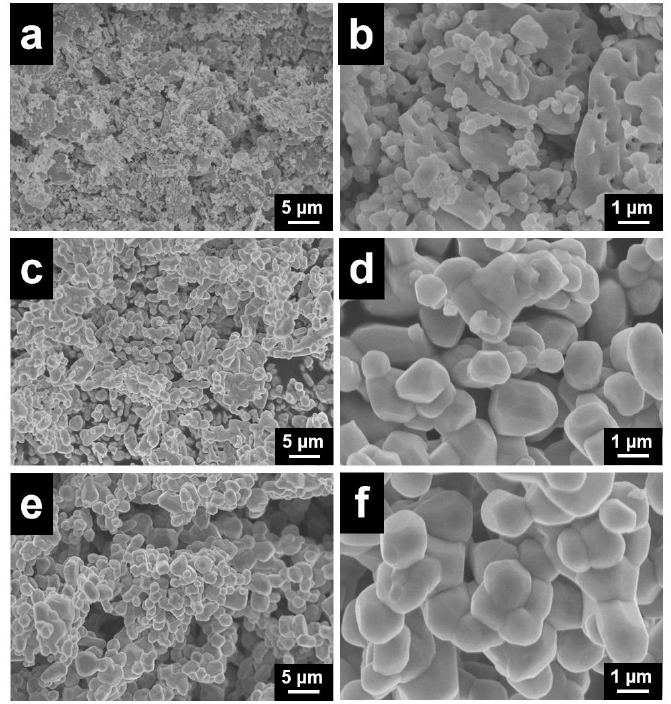
Figure 3. SEM images of the CuCo 2 O 4 -N ( a , b ), CuCo 2 O 4 -A ( c , d ) and CuCo 2 O 4 -C ( e , f ) catalysts.